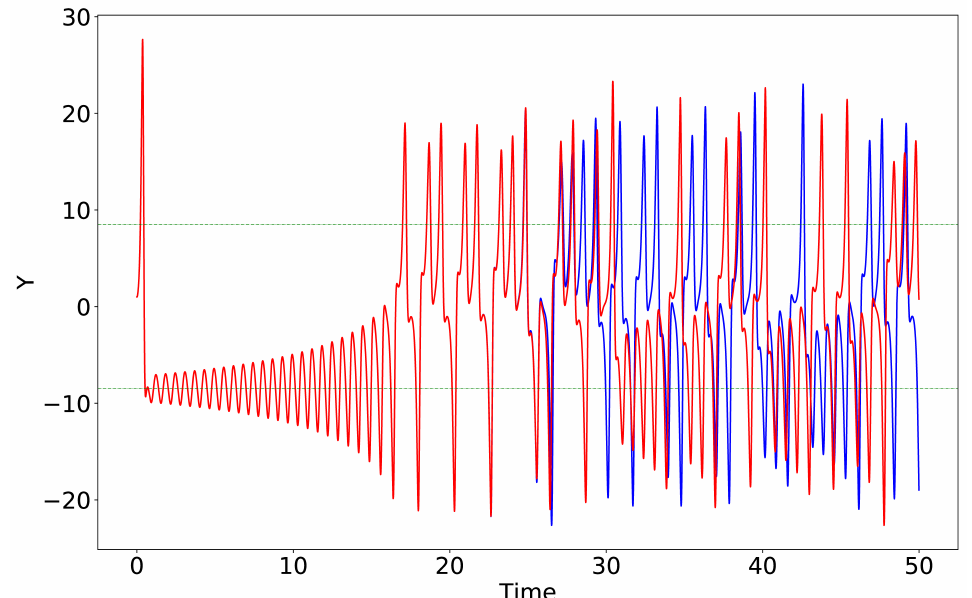
Figure 3: Two nearby trajectories within the L63 model with r = 28 and σ = 10. Solutions, in different colors, were obtained from the control and parallel runs. The only difference between the two solutions is that the parallel run adds a small perturbation (1 10 − 10 ) into the initial value of Y. The sensitive dependence of solutions on the initial conditions is indicated by the divergence of two orbits in blue and red. The two horizontal lines indicate the location of the non-trivial critical points.